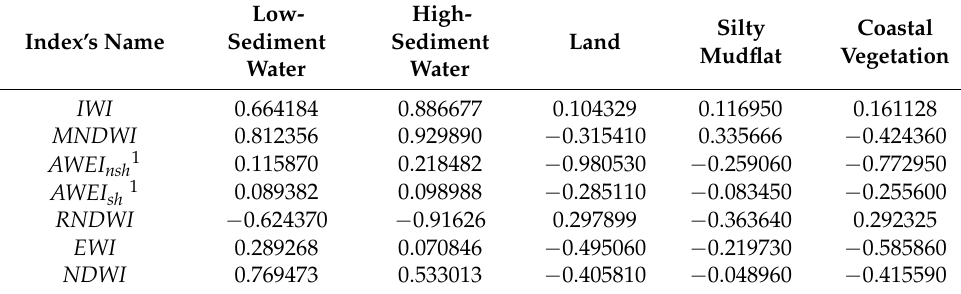
Table 3. Calculation results of each index are based on Figure